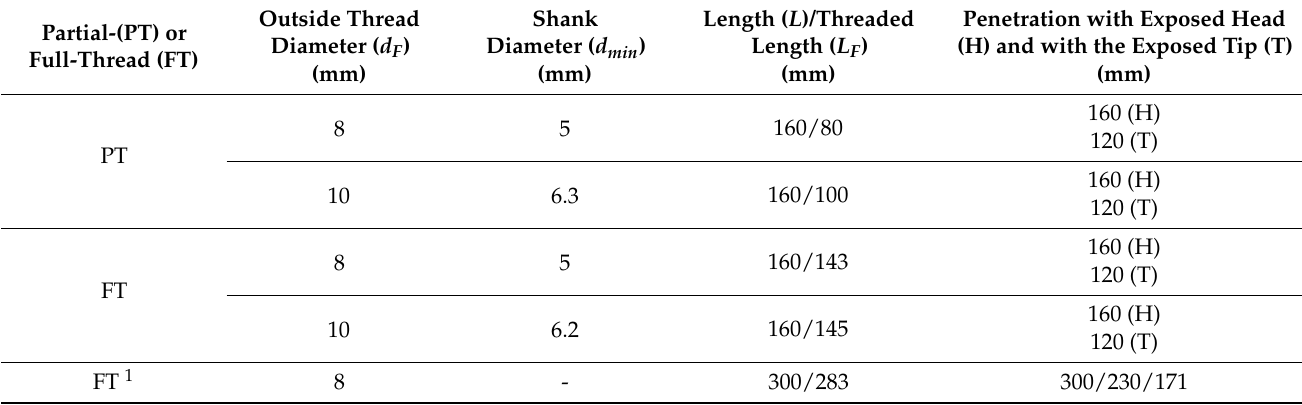
Table 2. Dimensions of bolts (using a 38.1 mm (1 1